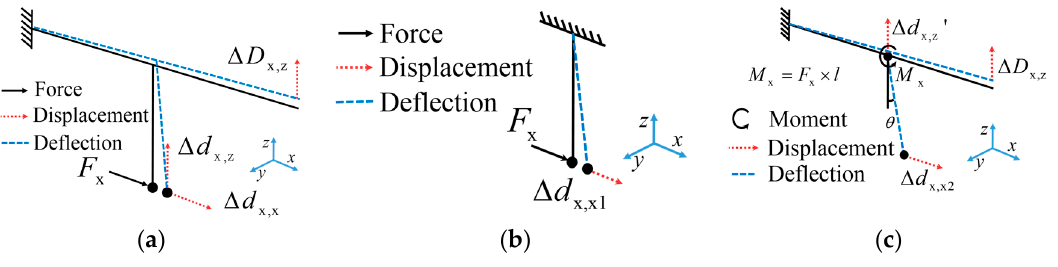
Figure 3. The ACF probe was split and analyzed separately: ( a ) the contact force along the x-axis subject to probing sphere; ( b ) the deflection of the shaft; and ( c ) the deflection of the cantilever.